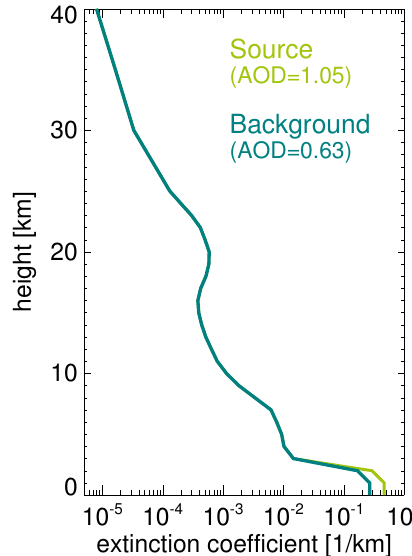
Fig. 5. Aerosol extinction profiles at 550nm used in the radia- tive transfer simulations to estimate the potential overestimation of the retrieved regional anthropogenic XCO 2 enhancement due to aerosols in the case of China. We use an anthropogenic aerosol type consisting of 50% soot and about 50% water soluble aerosol, as well as traces of insoluble aerosol (dust) in the lowest 10km. Note that the extinction coefficient is shown on a logarithmic scale. Also given are corresponding aerosol optical depths at